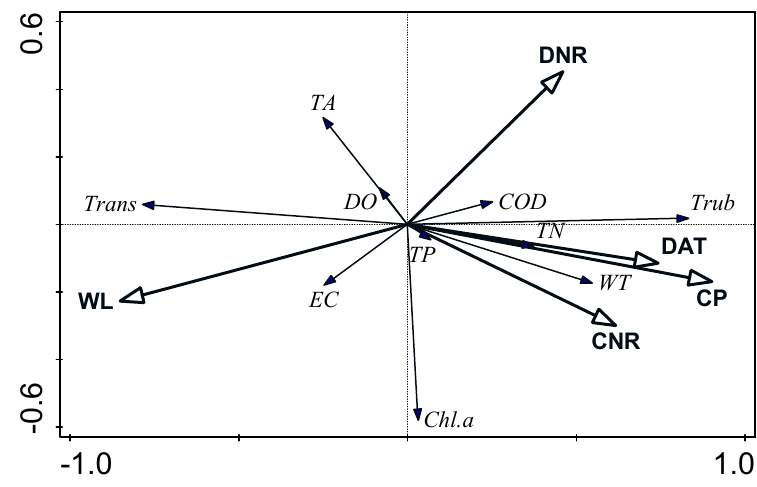
Figure 7. RDA ordination biplot of water environment variables and meteo-hydrological factors in the fluctuation backwater area of LR, China.